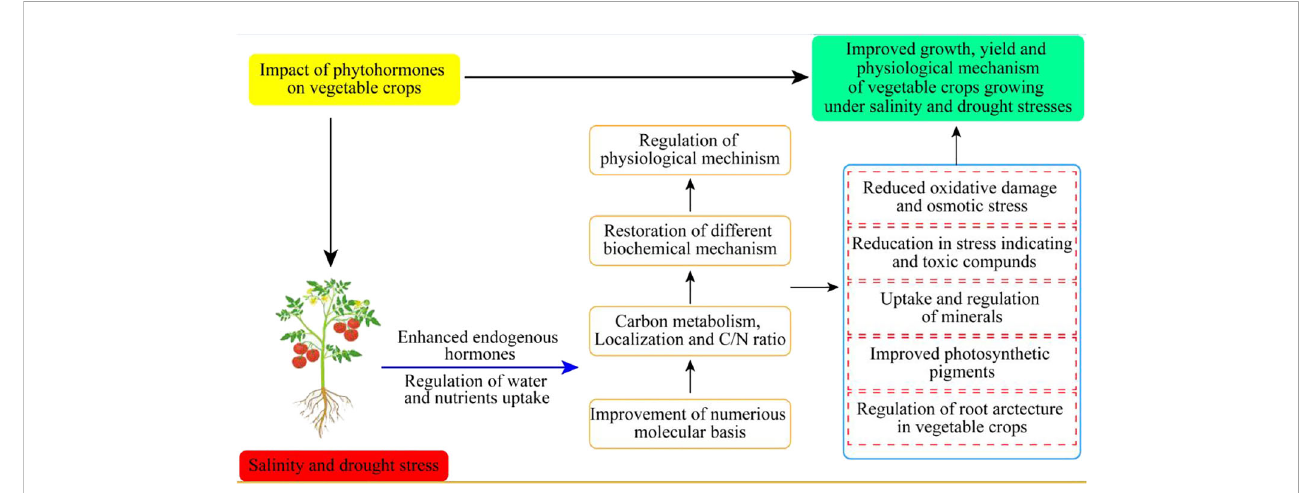
FIGURE 2 Critical stages of irrigation water at different growth stages of vegetable